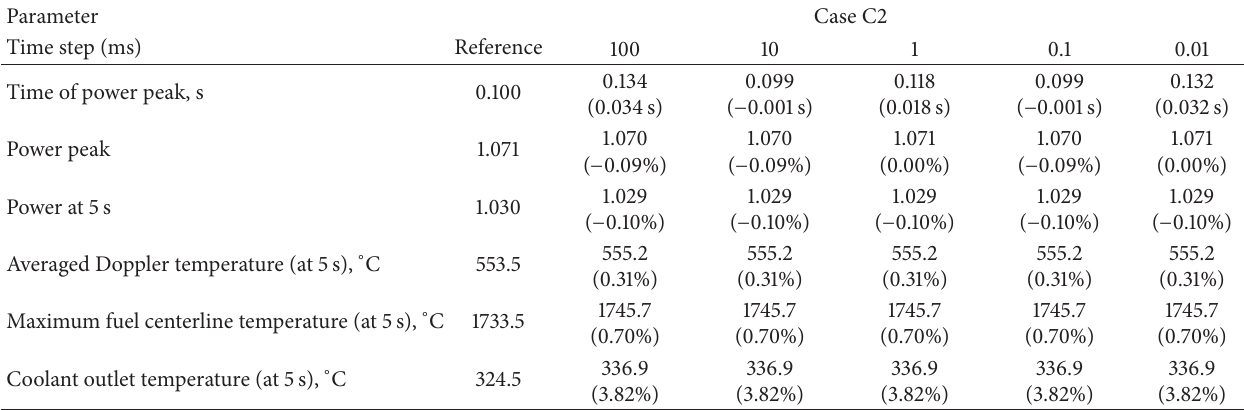
Table 9: Sensitivity analysis results in the maximum time step for case C2.